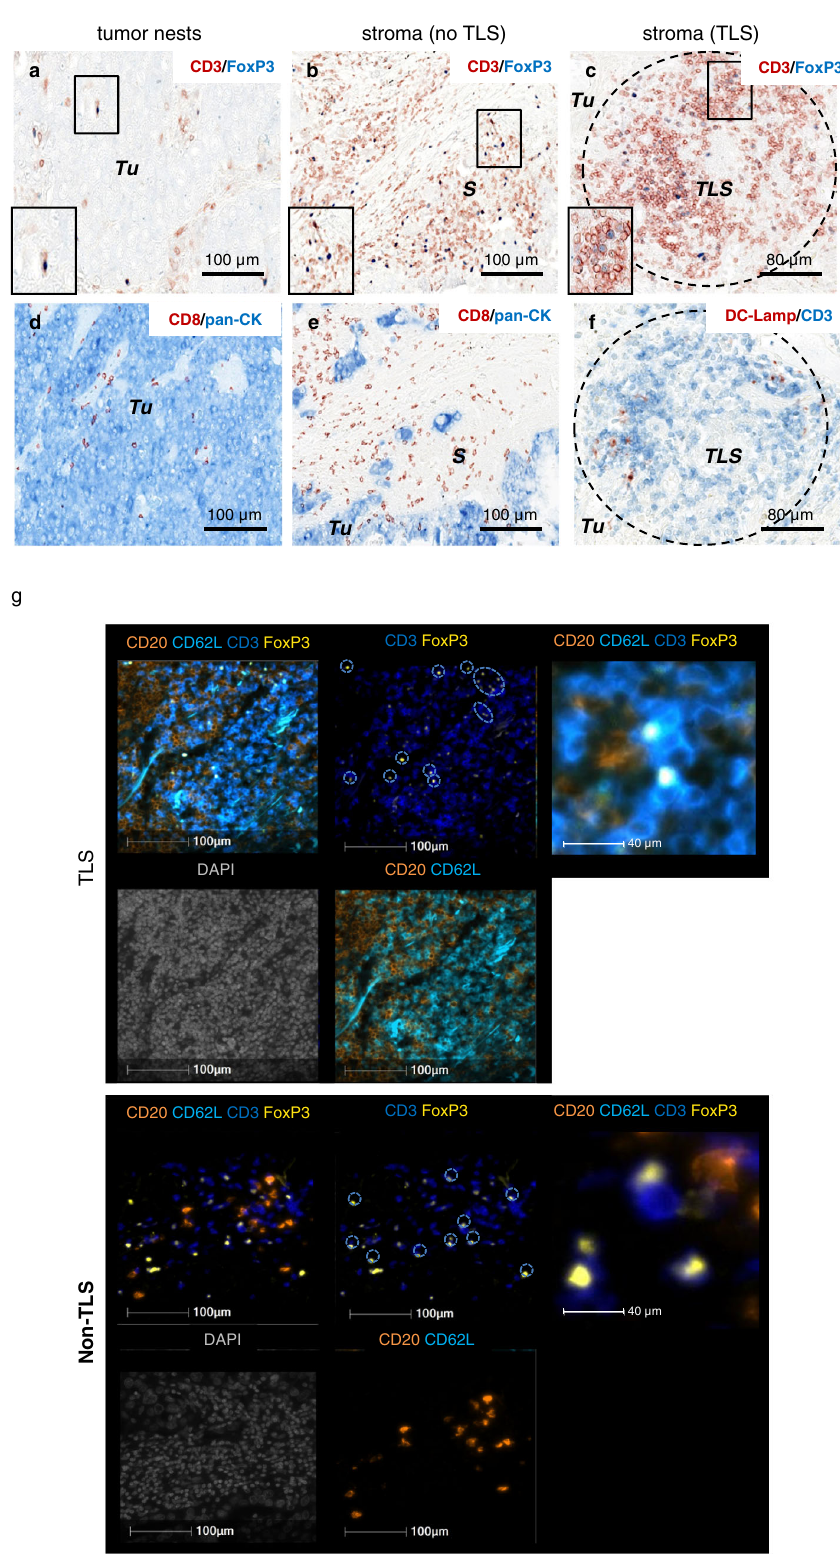
Fig. 1 Tregs in fi ltrate different lung tumor areas. Double IHC ( a – f ) and 5-plex IF staining ( g ) on paraf fi n-embedded lung tumor sections. Presence of CD3 + (red) FoxP3 + (blue) T cells in tumor nests ( a ), stroma ( b ), and TLS ( c ). Presence of CD8 + T cells (red) in pan-cytokeratins + (blue) tumor beds ( d ) and pan-cytokeratins - stroma ( e ). f Detection of DC-Lamp + (red) mature DC and CD3 + (blue) T-cell rich areas of TLS (encircled in black dotted line). Serial sections: a – d , b – e , and c – f . g 5plex-IF staining (DAPI in gray, CD3 in dark blue, FoxP3 in yellow, CD20 in orange, and CD62L in light blue) in TLS and tumor